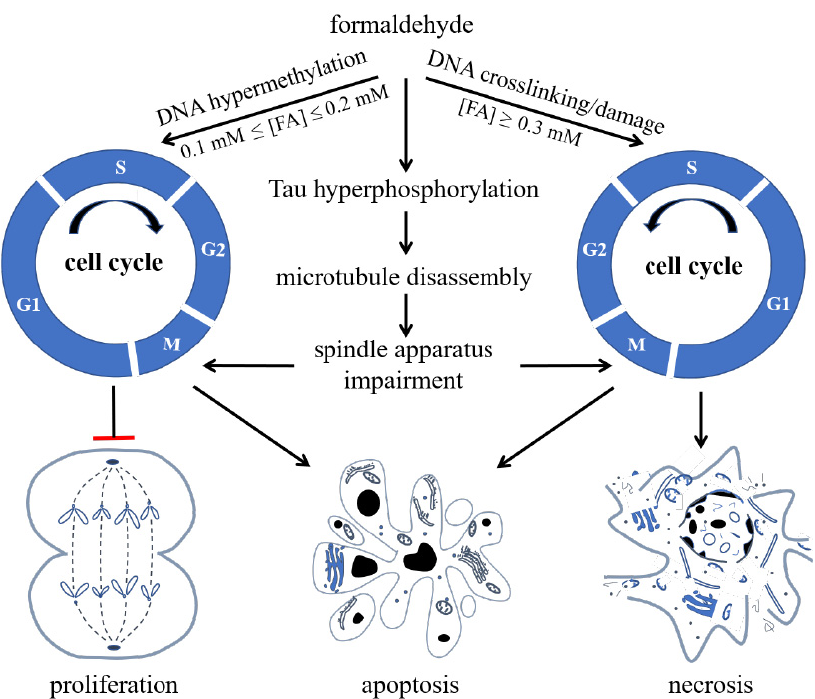
Figure 3. Formaldehyde (FA) inhibits cell proliferation and induces cell apoptosis and necrosis via its effect on cell cycle. FA induces hypermethylation of DNA when 0.1 mmol/L ≤ (FA) ≤ 0.2 mmol/L, and causes crosslinking or damage of DNA, arresting cells at S phase and restraining cells from entering G2/M phase when (FA) ≥ 0.3 mmol/L, reproduced with permission from Miao et al. [9]. These results suggest that FA may be a risk factor for sporadic ARCI, although it is not